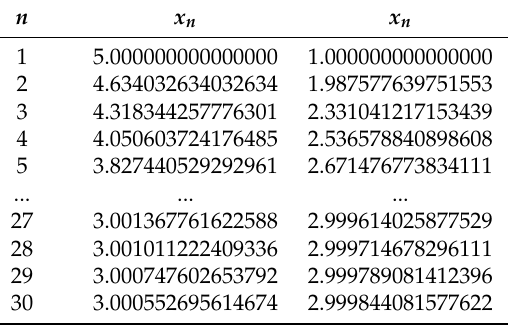
Figure 1. Weak convergence of { x n } . Table 1. The values of the sequence x n